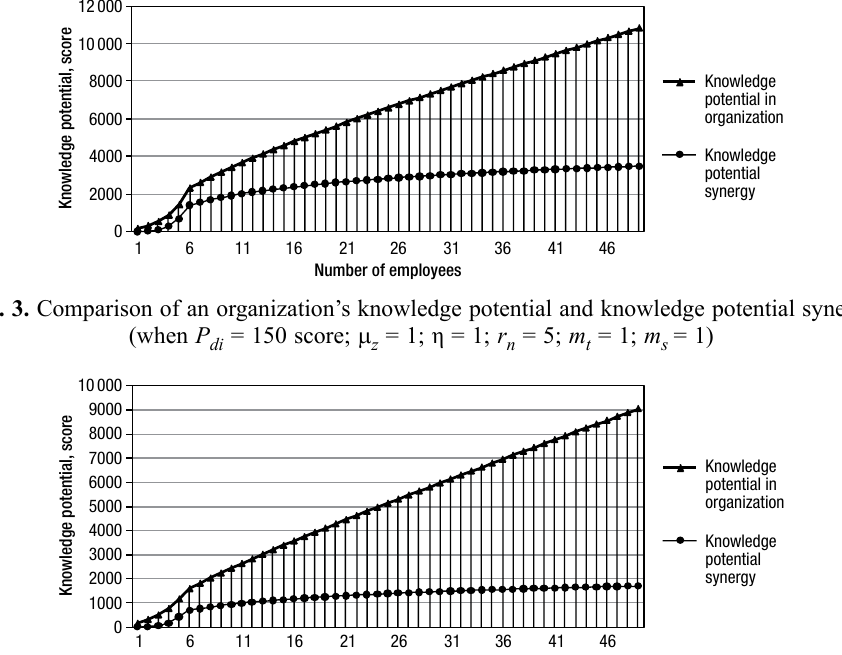
Fig. 4. Comparison of an organization’s knowledge potential and knowledge potential synergy